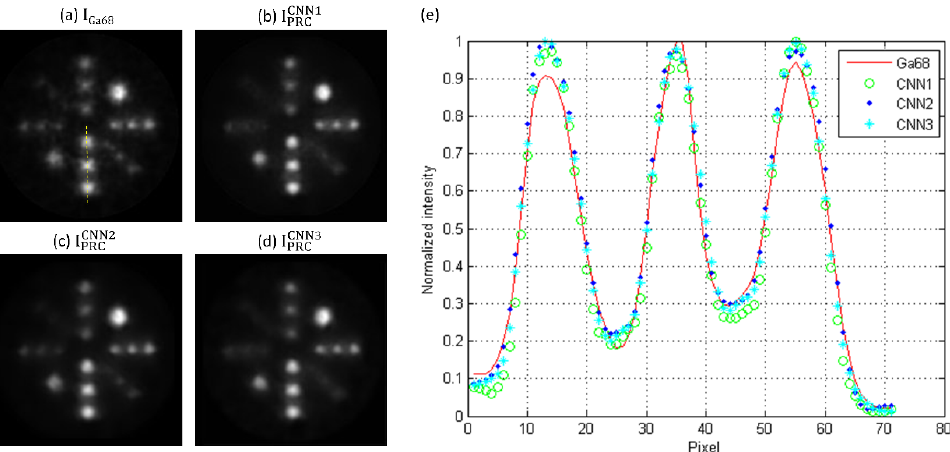
Figure 8. ( a ) I Ga68 , ( b ) I CNN1 , ( c ) I CNN2 , ( d ) I CNN3 of PHAN 20rod and ( e ) comparison of intensity profiles through the dashed Figure 8. ( a ) I , ( b ) I (cid:2900)(cid:2902)(cid:2887)(cid:2887)(cid:2898)(cid:2898)(cid:2869) , ( c ) I (cid:2900)(cid:2902)(cid:2887)(cid:2887)(cid:2898)(cid:2898)(cid:2870) , ( d ) I (cid:2900)(cid:2902)(cid:2887)(cid:2887)(cid:2898)(cid:2898)(cid:2871) of PHAN and ( e ) comparison of intensity profiles through the dashed PRC PRC PRC Ga68 20rod line in ( a line in ( a ).